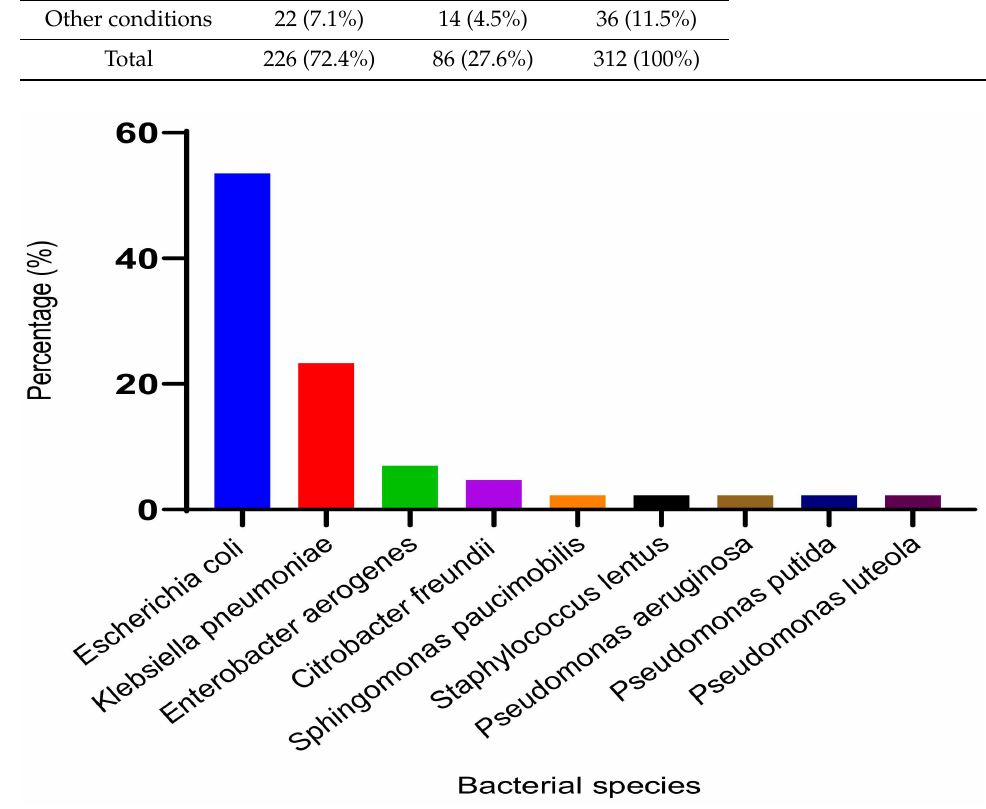
Figure 2. Percentage of bacterial species involved in urinary tract